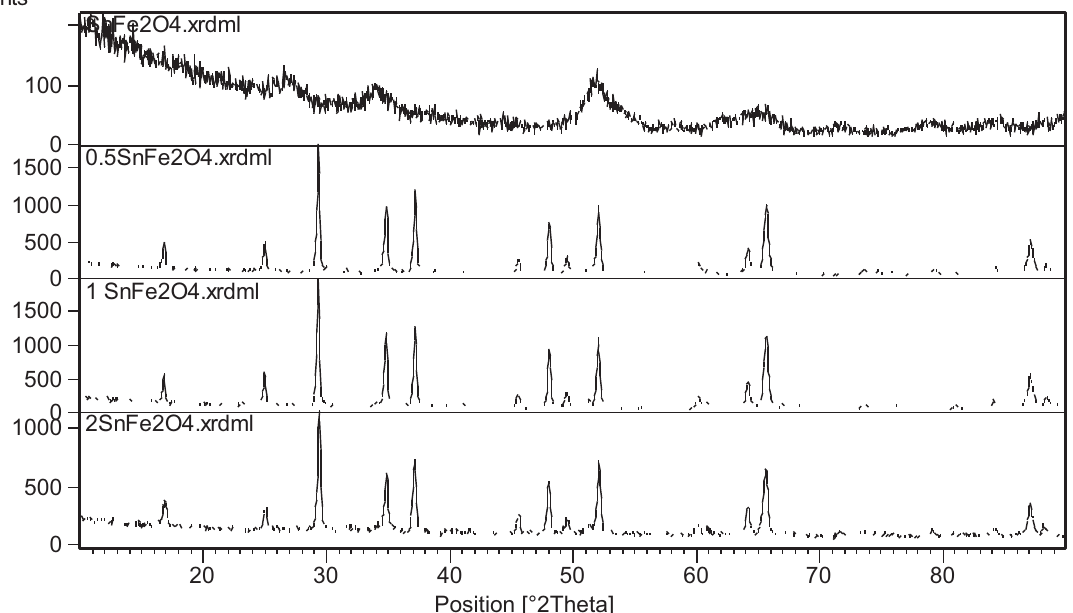
Figure 1: XRD patterns of pure SnFe sodium silicate.